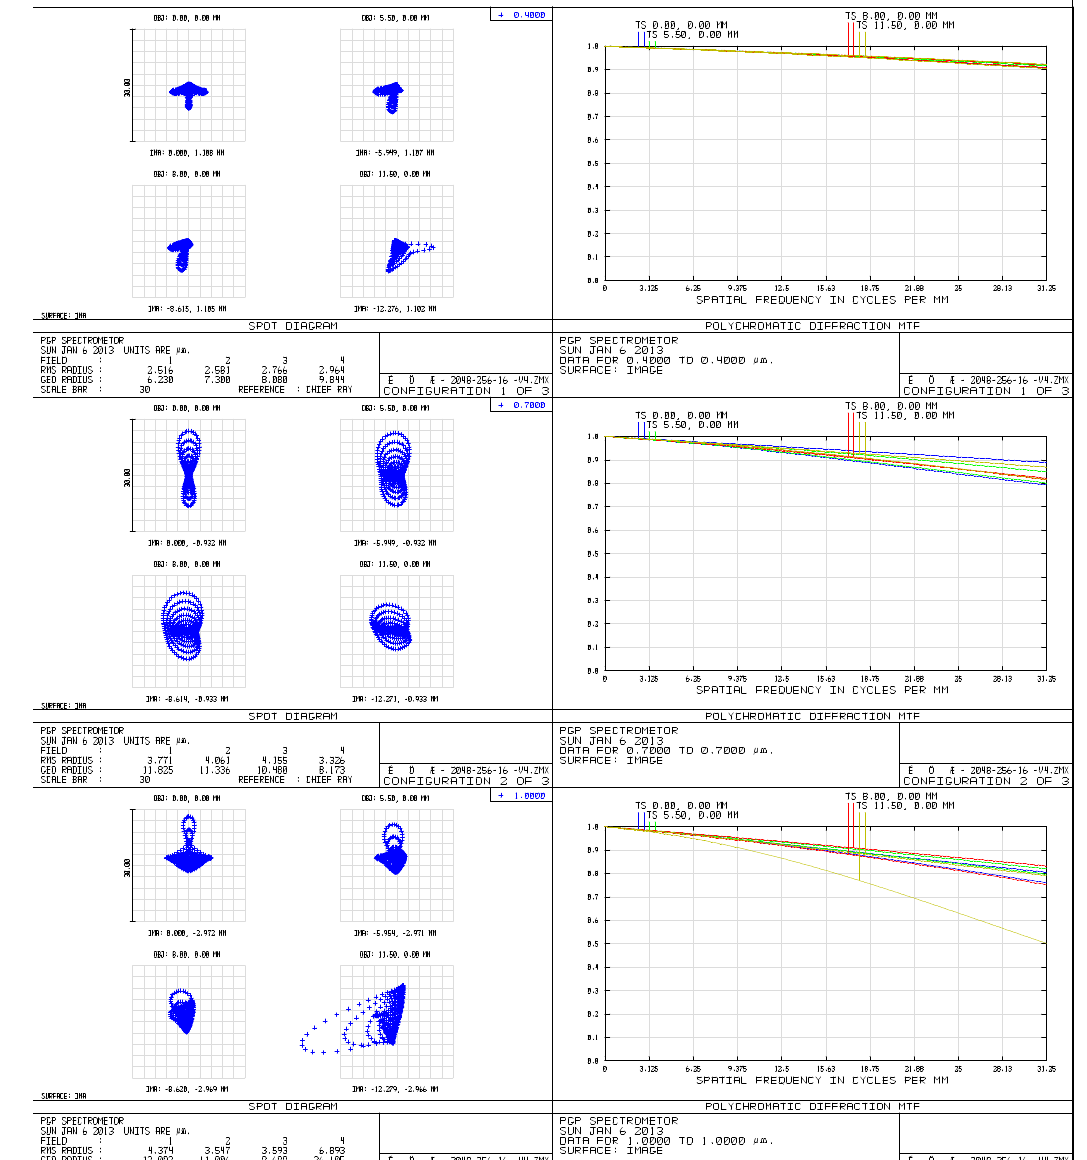
Figure 3. Modulation Transfer Function (MTF) curve and spot map of the optical system at 0.4 μm, 0.7 μm and 1 μm (left are spot maps, and right are MTF curve).